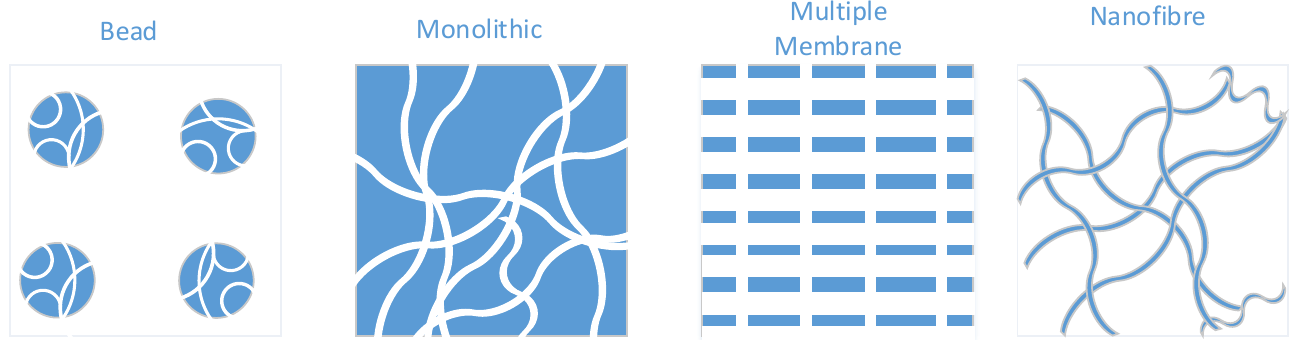
Figure 1. Illustrative examples of chromatography resins in use for lentiviral vector purification with increasing convective mass transfer from left to